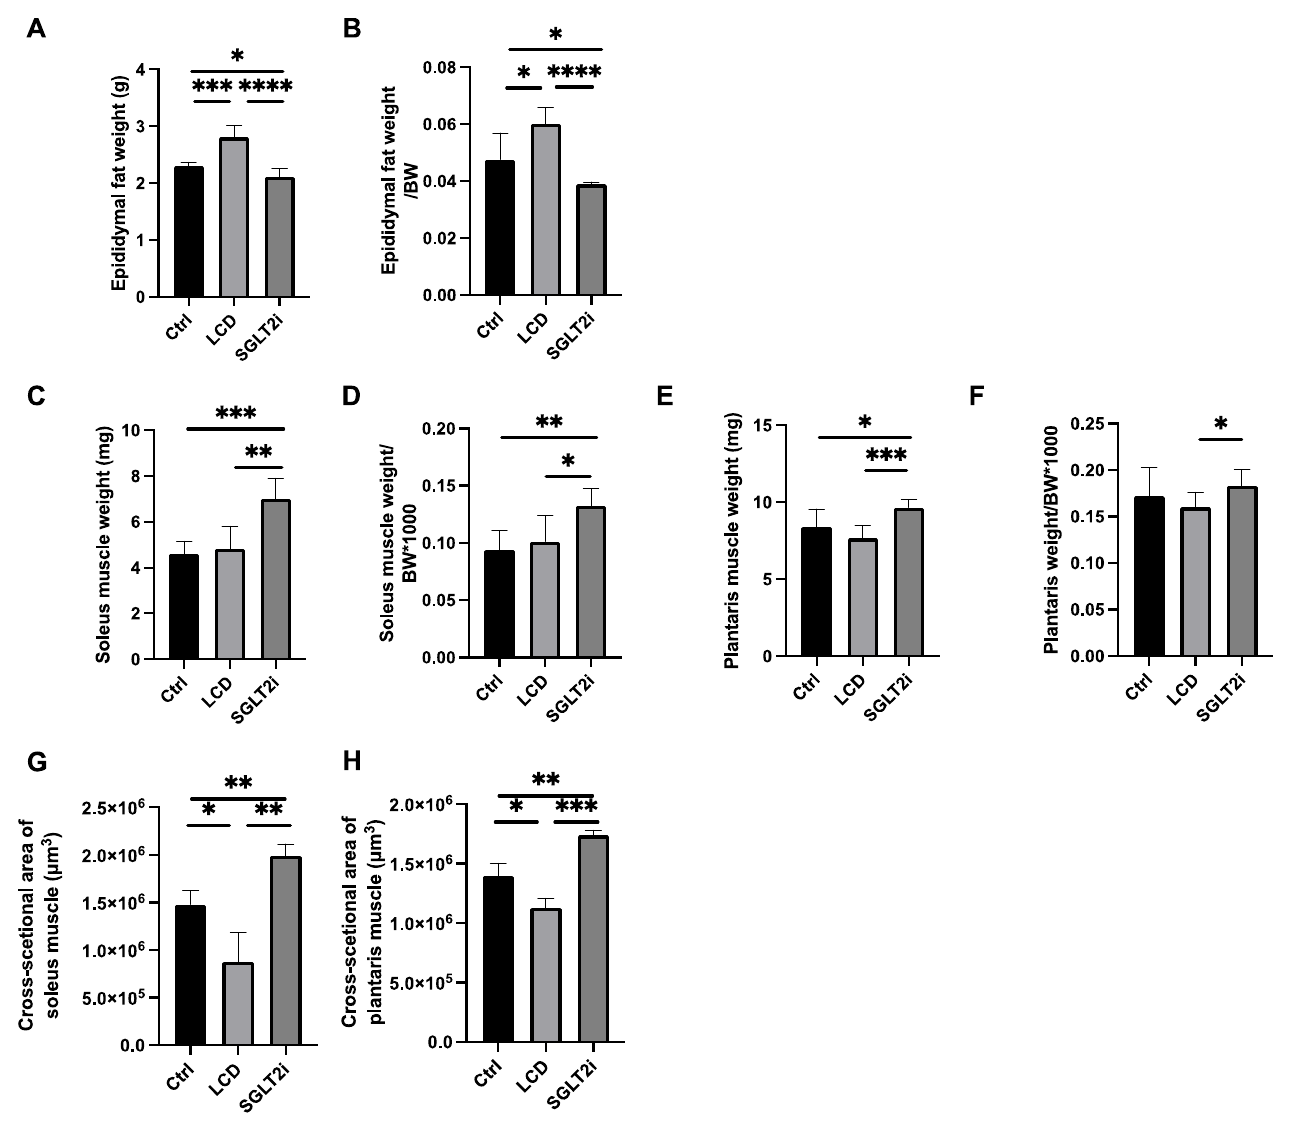
Figure 2. LCD increased visceral fat weight and decreased skeletal muscle, whereas SGLT2i decreased visceral fat weight and increased skeletal muscle. ( A , B ) Absolute and relative epididymal fat weights. ( C , D ) Absolute and relative soleus muscle weights. ( E , F ) Absolute and relative plantaris muscle weights. ( G , H ) Cross-sectional areas of the soleus and plantaris muscles. Data are mean ± SD. One ‐ way ANOVA was conducted for statistical analysis. * p < 0.05, ** p < 0.01, *** p < 0.001, and **** p < 0.0001.